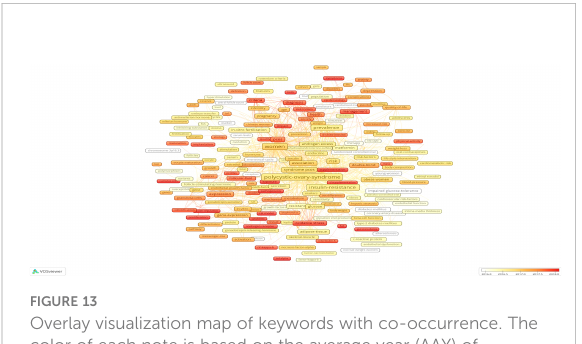
FIGURE 13 Overlay visualization map of keywords with co-occurrence. The color of each note is based on the average year (AAY) of keyword, as shown by the color gradient at the bottom